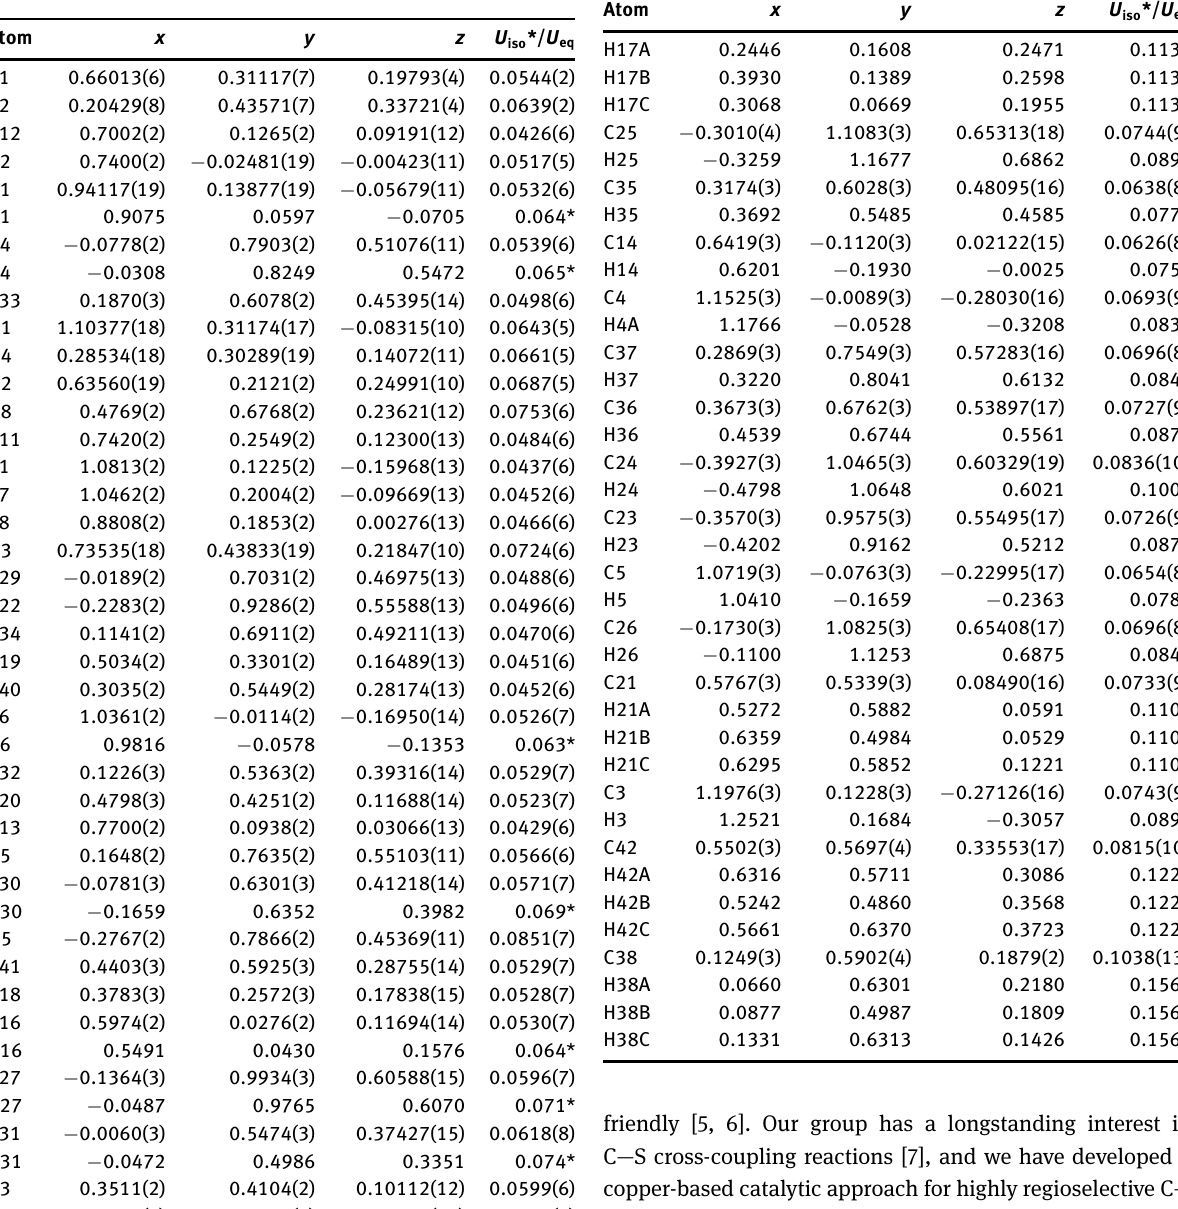
Table 2: Fractional atomic coordinates and isotropic or equivalent isotropic displacement parameters (Å 2